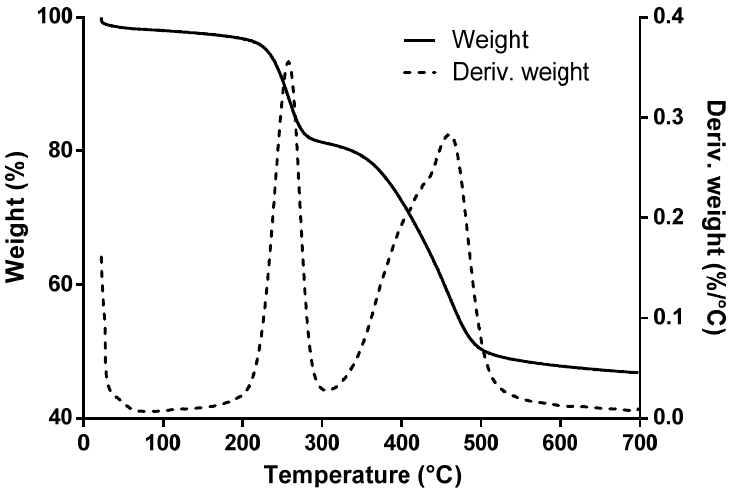
Figure 2. TGA curve for L-NPs showing thermal decomposition of CTAB (200–300 °C) and LO (300– 550 °C). TGA was done under UHP nitrogen atmosphere. (300–550 ◦ C). TGA was done under UHP nitrogen